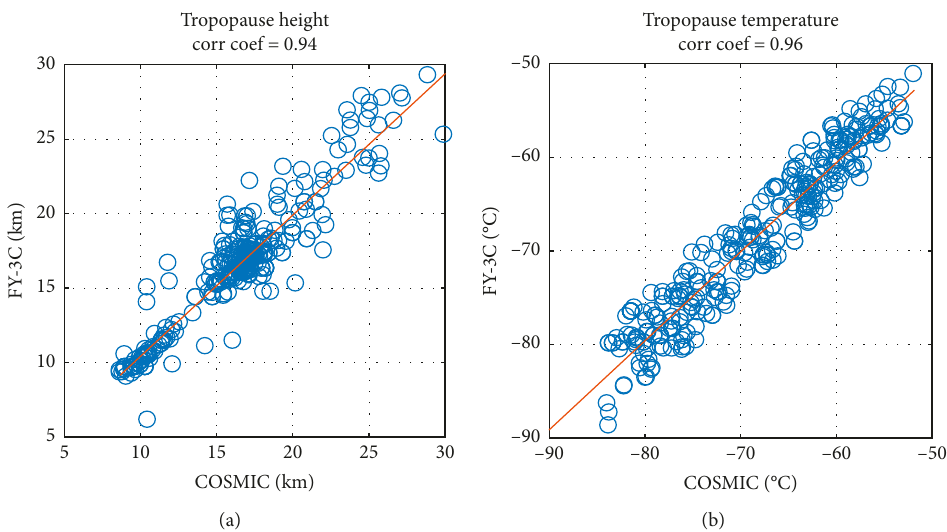
Figure 8: Comparison of the tropopause height (a) and temperature (b) obtained from FY-3C and COSMIC occultation data.